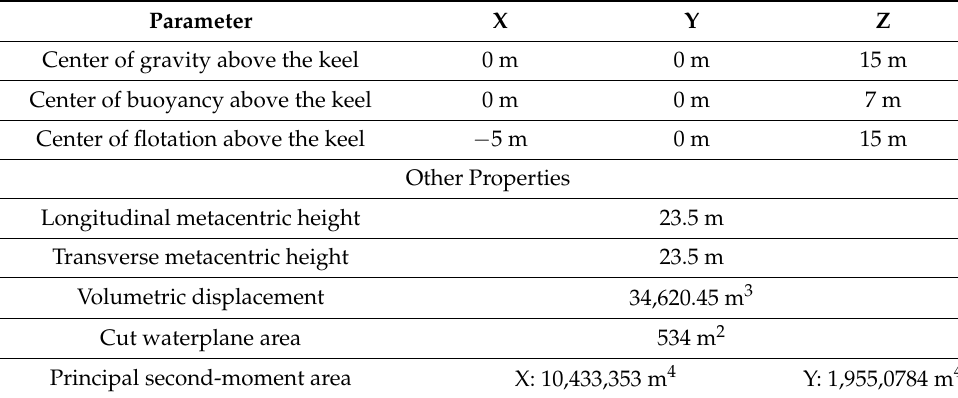
Table 6. Hydrostatic results of the floating platform.